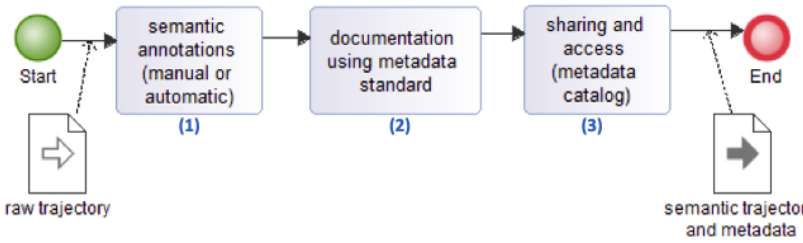
Figure 4. Diagram representing STMO documentation in